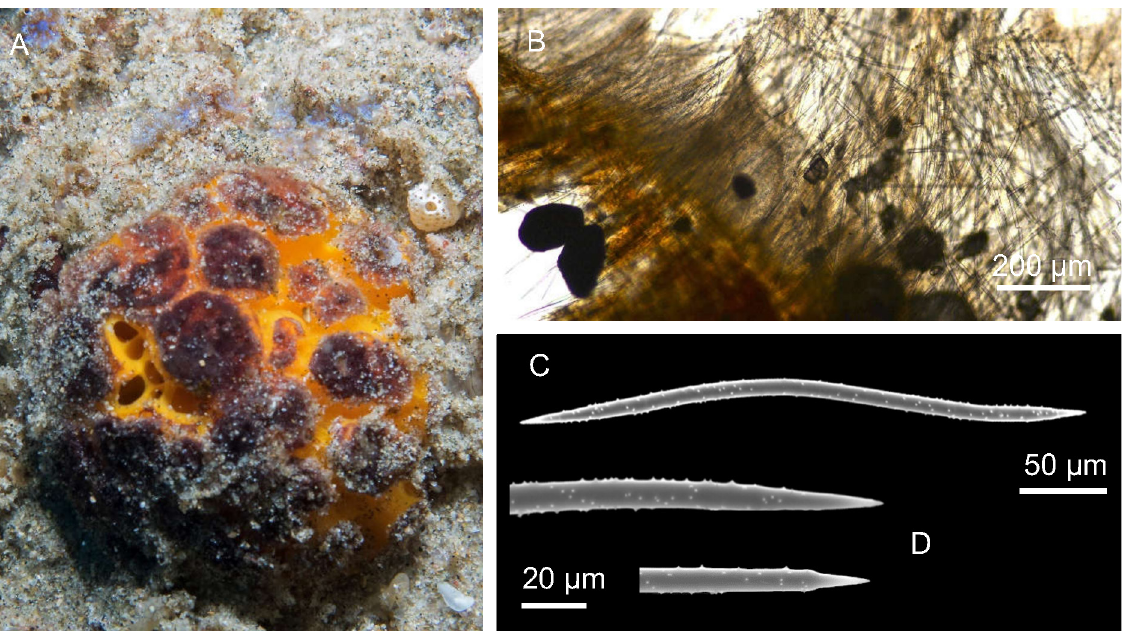
Fig. 12. Myrmekioderma granulatum (Esper, 1829). A . Specimen PO98 in situ . B . Ectosomal skeleton. C . Microspined and flexuous oxea. D . Magnifications of the